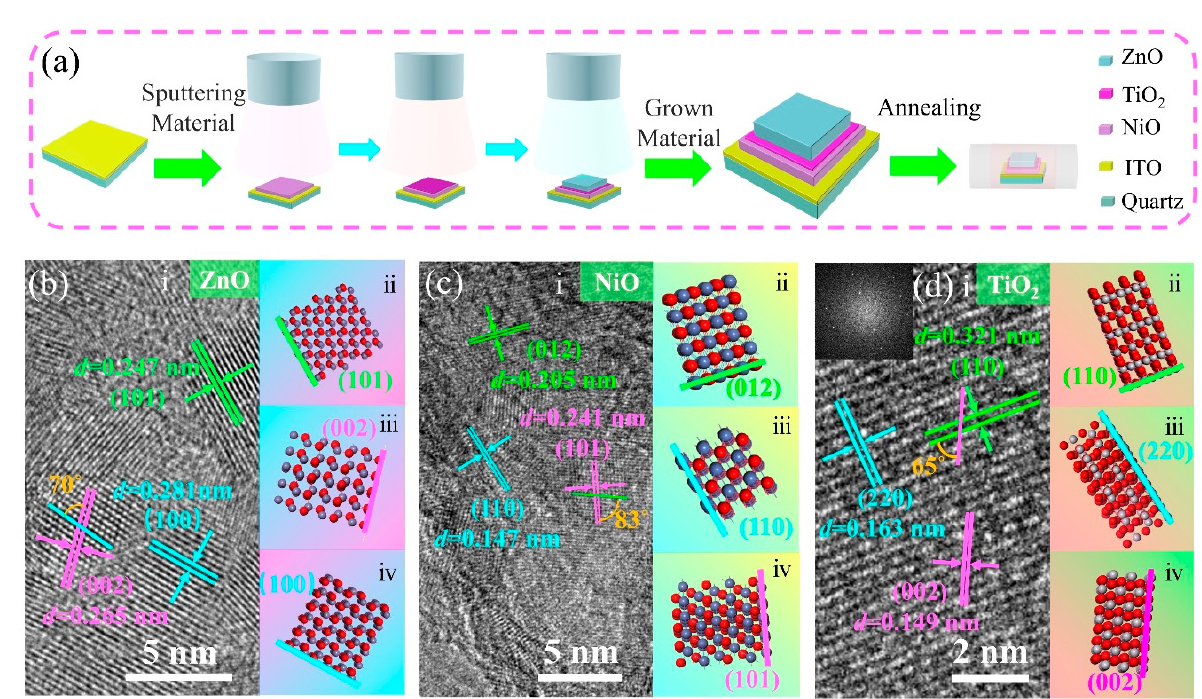
Figure 1. ( a ) Schematic diagram illustrating the preparation process of the films. ( b – d ) TEM images of ZnO, NiO, and TiO 2 (insets show the atomic spatial arrangements of the crystal planes), respec-